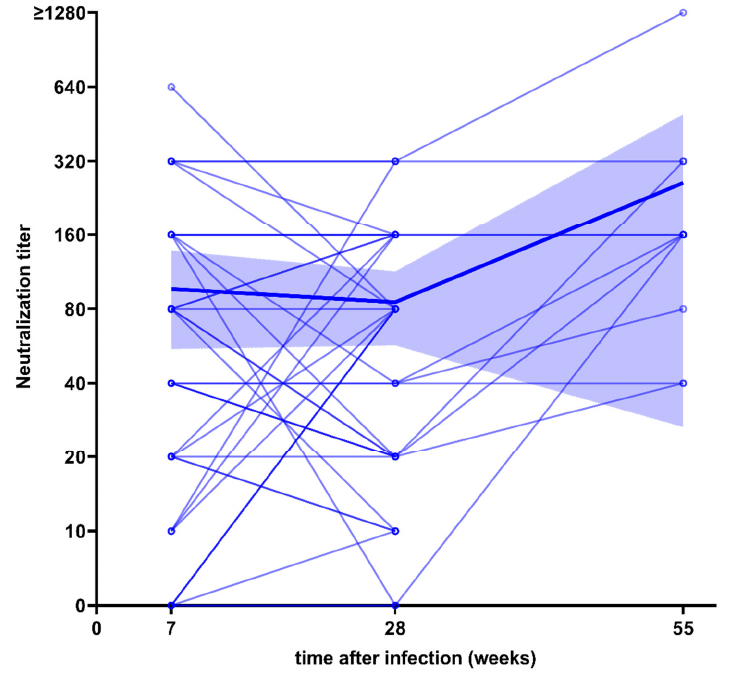
Figure 3. Longitudinal course of neutralization titers in 40 serum samples of participants after infection with SARS-CoV-2 over 28 weeks, with data for 11 serum samples over 55 weeks. The highlighted blue graph shows the mean neutralization titer with its 95% confidence interval.